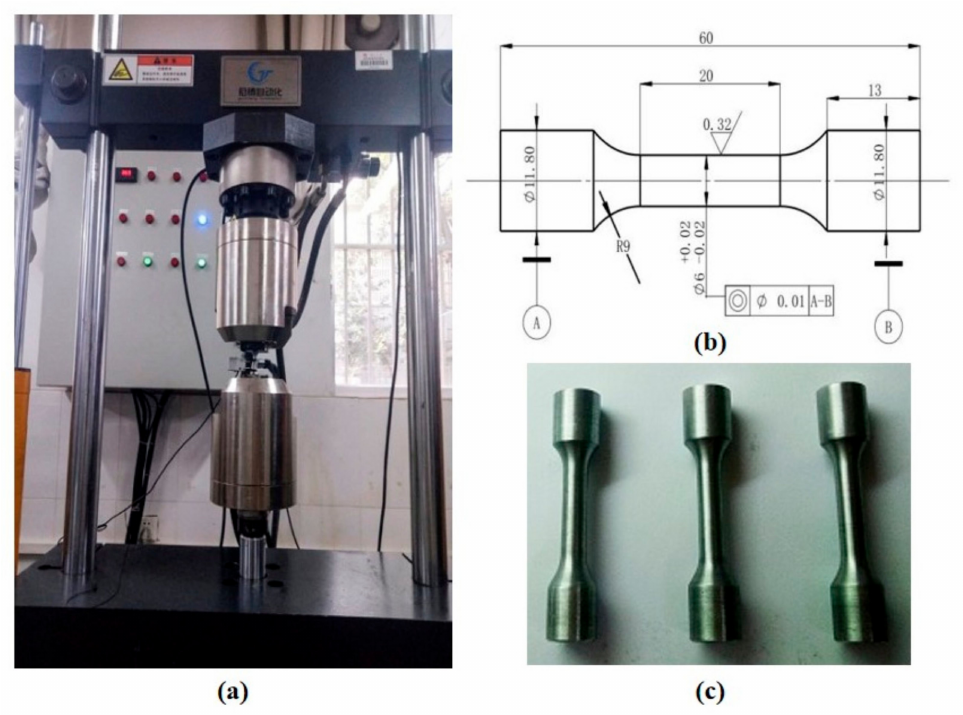
Figure 1. ( a ) The tested fatigue machine ( b ) Geometric dimensions of the cylindrical specimen for strain-controlled LCF tests (unit: mm) ( c ) The tested